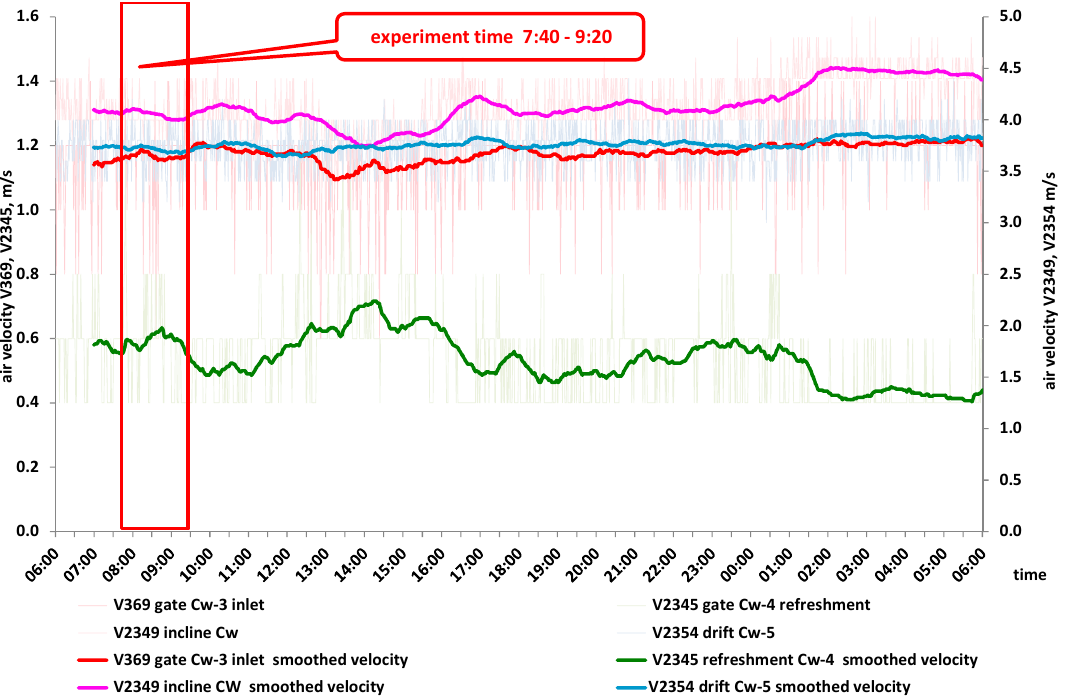
Figure 3. Smoothed air velocity data curves for the longwall Cw-4 area on 14 January